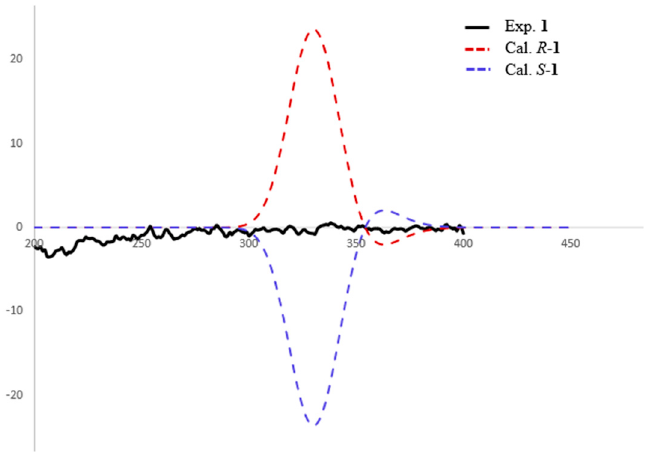
Figure 3. Experimental and calculated ECD spectra of compound 1 (in MeOH).